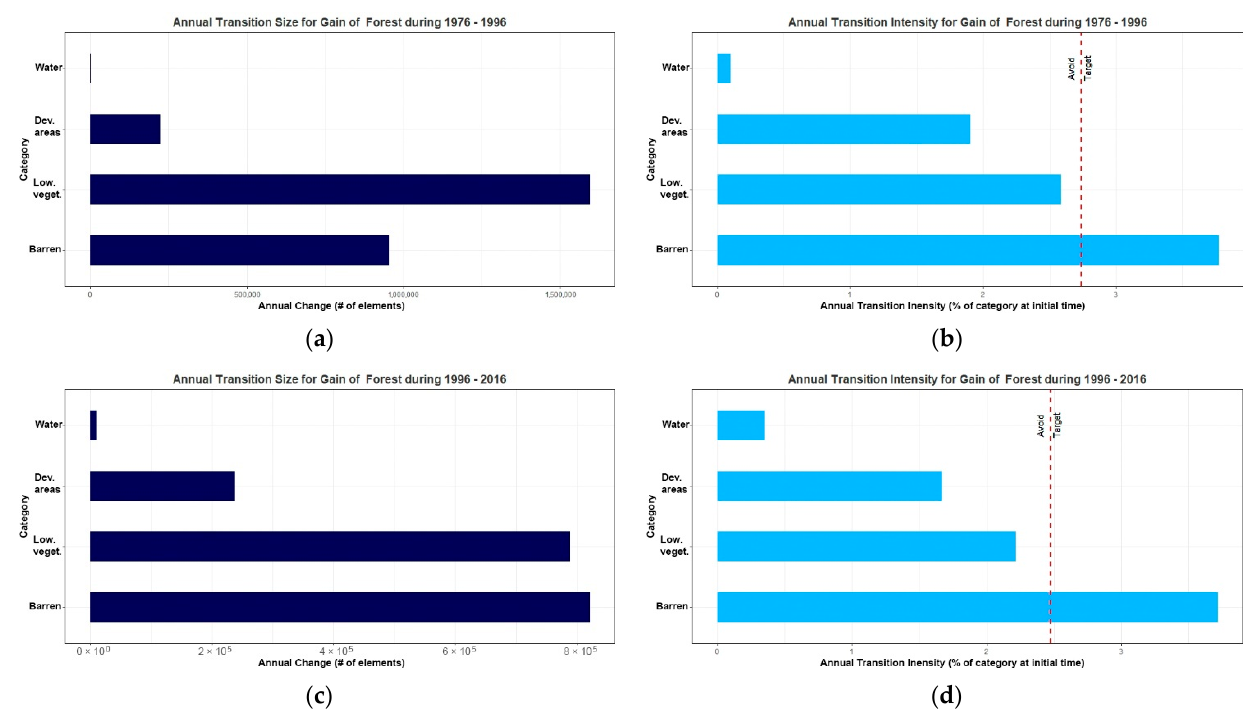
Figure 12. Annual gain transitions of forest class during 1976–1996 and 1996–2016; ( a ) annual transition size for gain of forest during 1976–1996; ( b ) annual transition intensity for gain of forest during 1976–1996; ( c ) annual transition size for gain of forest during 1996–2016; ( d ) annual transition intensity for gain of forest during 1996–2016.